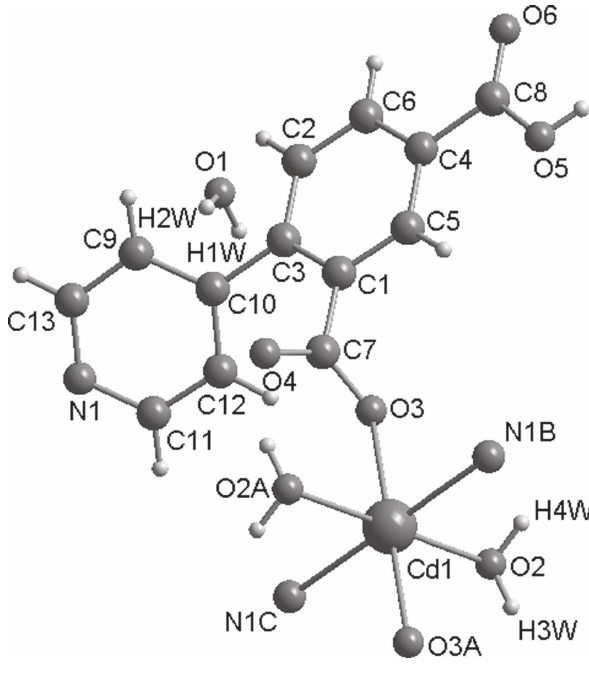
Table 1: Data collection and handling.